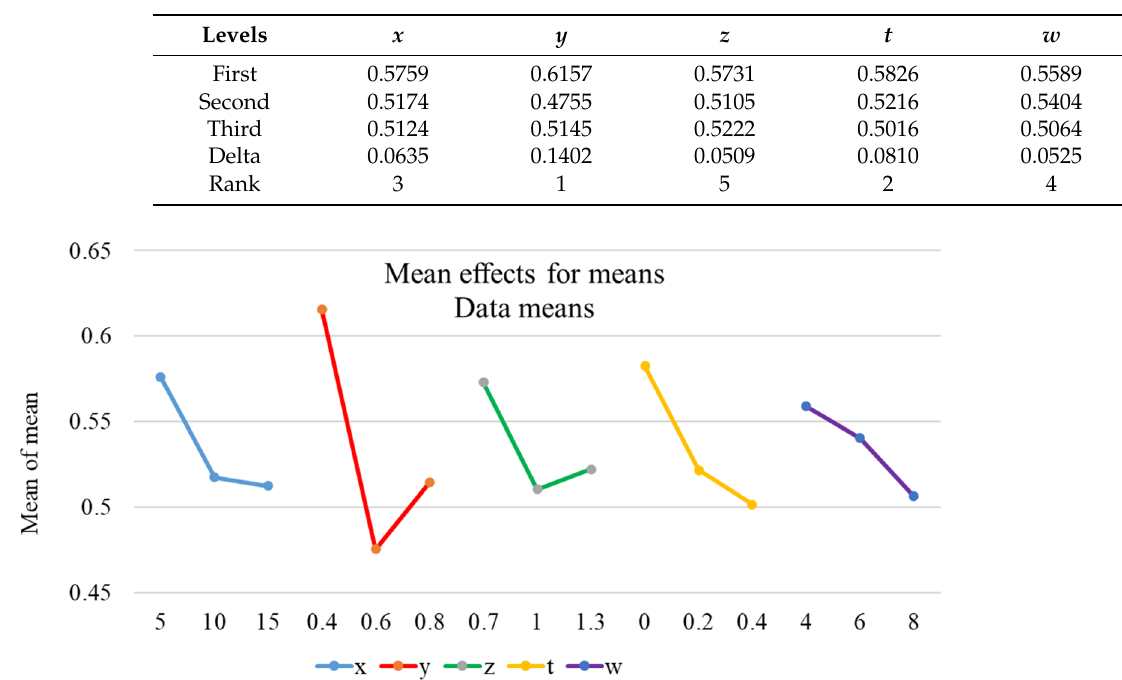
Figure 4. The result of mean analysis.